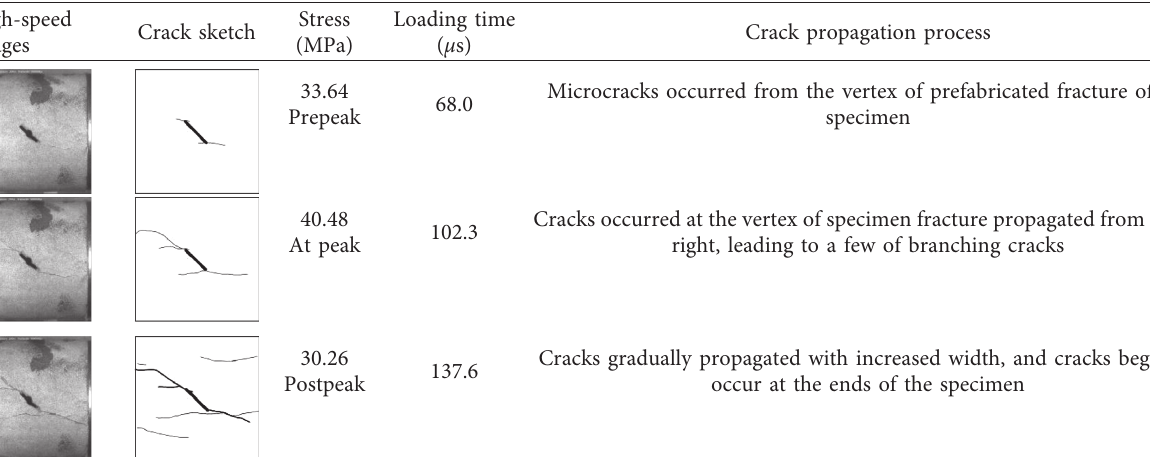
Table 5: Crack propagation process of Specimen a2 at the loading rate of 10.6m/s. High-speed Crack images